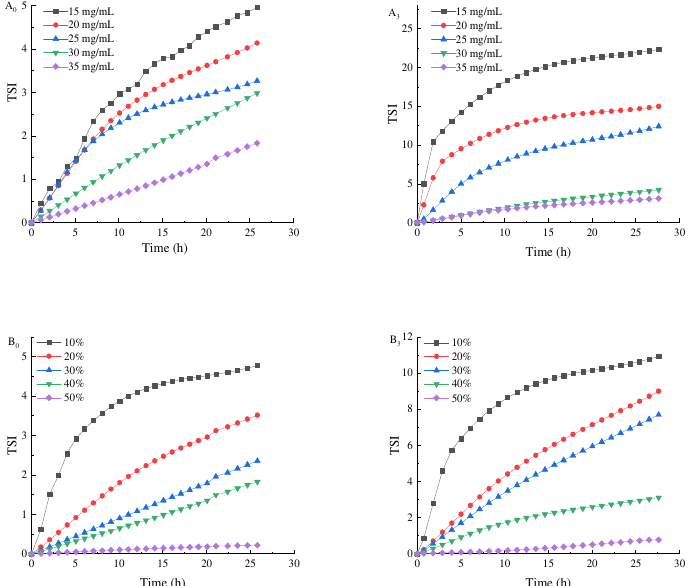
Figure 4. TSI of Pickering emulsions made by different oil phase volume fractions and different concentrations of SPI and maltose. (( A 0 ) prepared the initial emulsion with different concentrations of SPI and maltose, ( B 0 ) prepared the initial emulsion with different oil phase volume fractions, ( A 3 ) was the emulsion after three freeze-thaw cycles with different concentrations of SPI and maltose, ( B 3 ) was the emulsion after three freeze-thaw cycles with different oil phase volume fractions.) Firstly, the slope of the TSI curve of the Pickering emulsion after freeze–thaw cycle was higher than that of the initial emulsion, indicating that freezing would damage the Pickering emulsion and reduce its stability. This is because when the Pickering emulsion was frozen, oil phase or water phase in the Pickering emulsion crystallized to make the droplets gather, which destroyed the film at the oil–water interface of the Pickering emul- sion, making the Pickering emulsion easier to agglomerate during the dissolution process, and thus reducing its stability [21]. By increasing the concentration of SPI and maltose,